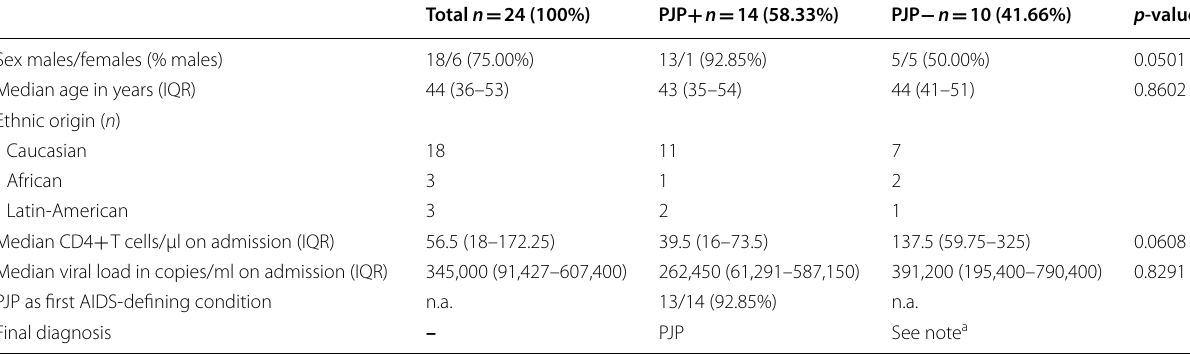
PJP, Pneumocystis jirovecii pneumonia; IQR, inter quartile range; n.a., not applicable a Final diagnoses of PJP-patients: bacterial pneumonia (n (n 1) with lung involvement, non-Hodgkin’s T cell lymphoma (n =